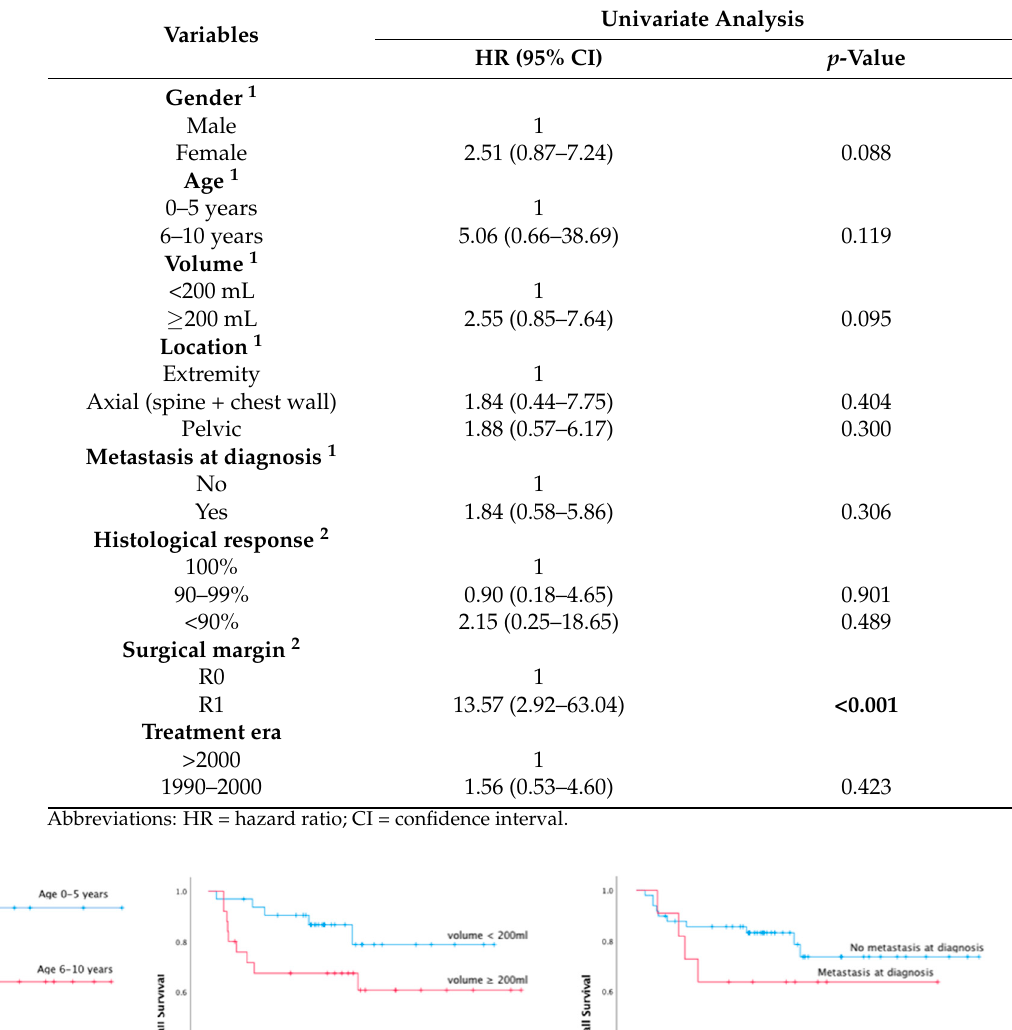
Table 3. Results of univariate Cox regression analysis at time of diagnosis 1 and time of surgery 2 .